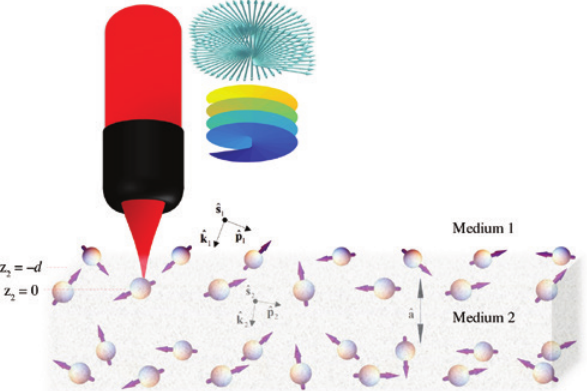
Figure 1: (Color online) Scheme for the optomagnetic recording via the IFE under tight focusing condition, with refraction at the interface in z = − d and focal plane in z = 0; vectors in media 1 and 2, respectively; associated unit polarization vectors perpendicular and parallel to the plane of incidence, respectively. Medium 2 is characterized by the uniaxial symmetry axis ˆ a perpendicular to the